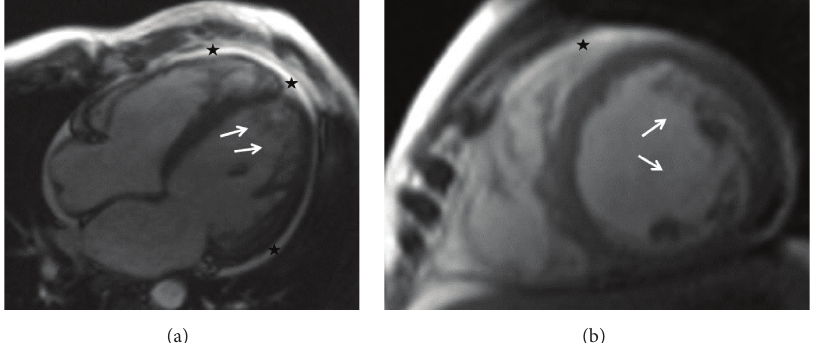
Figure 2: Cardiac MRI, cine mode, showing apical hypertrabeculation (arrows) and circumference pericardial effusion (asterisk) ((a) 4- chamber view, (b) midventricular 2-chamber